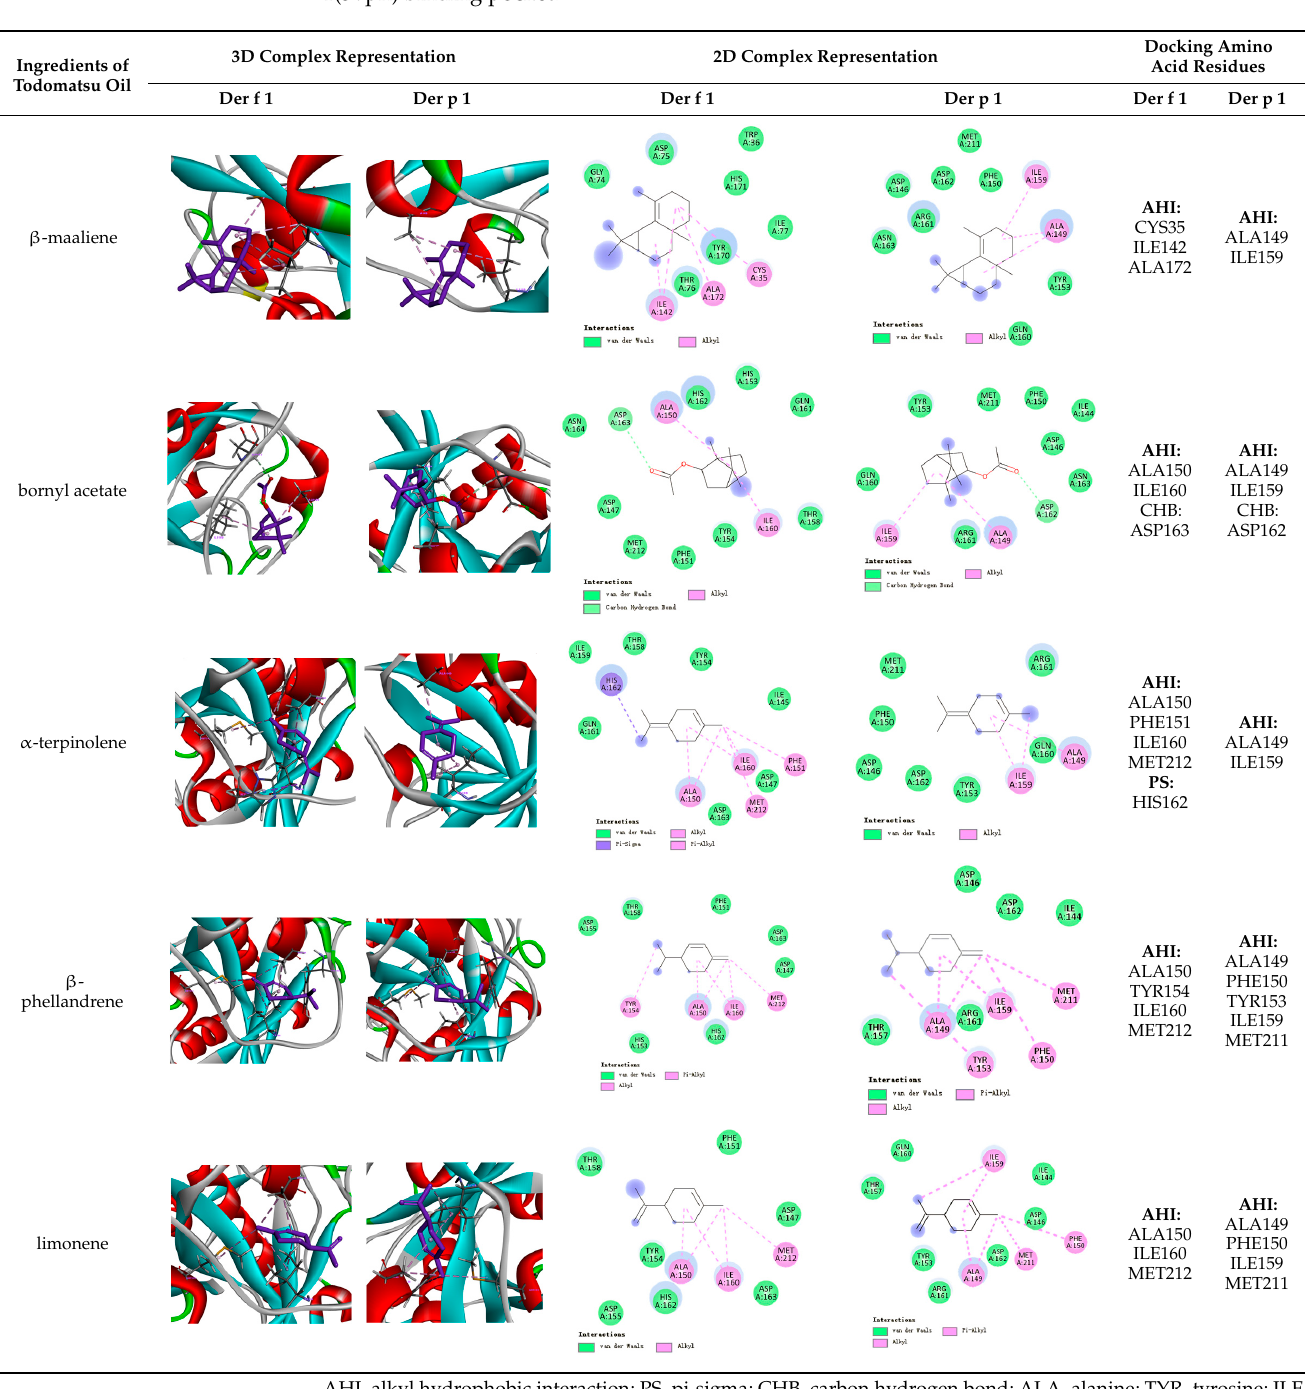
Table 3. 2D and 3D diagrams of top 5 ingredients of todomatsu oil on allergens Der f 1(5vpk)/Der p 1(5vph) binding pocket.